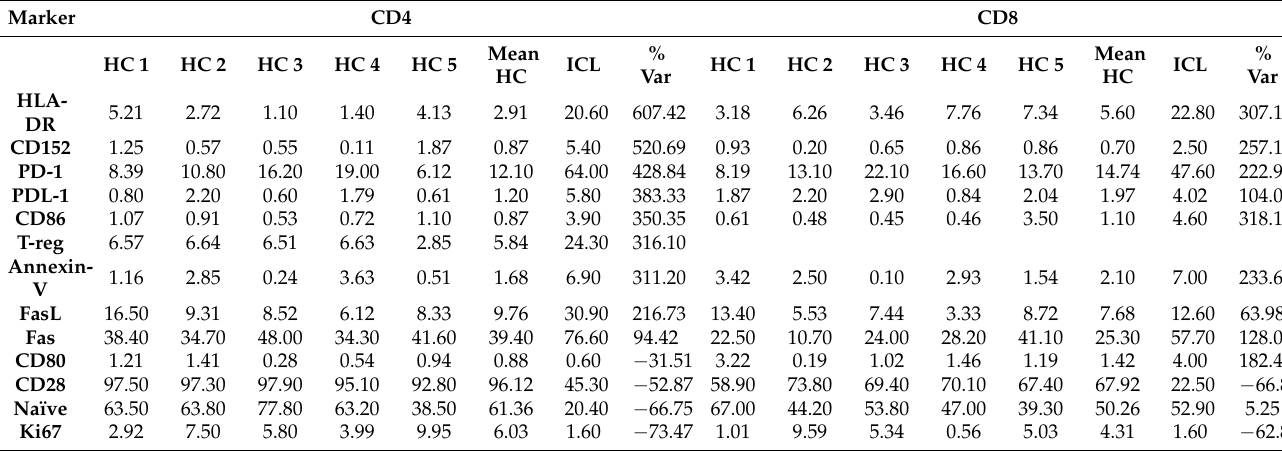
Table 1. T cell phenotype in idiopathic CD4 T cell lymphocytopenia (ICL) and 5 healthy controls (HC). Percentage of markers for activation (HLA-DR+), costimulatory and inhibitory molecules (CD28, CD80, CD86, CD152, PD-1, PDL-1), regulatory T cells (CD25+Foxp3+), apoptosis (AnnexinV+Propidium iodide, Fas, FasL), naïve T cells (CD54RA+CD62L+), and proliferation (Ki67+) expressed on CD4 and CD8 T cells from ICL patient and 5 healthy controls (HC 1-5).